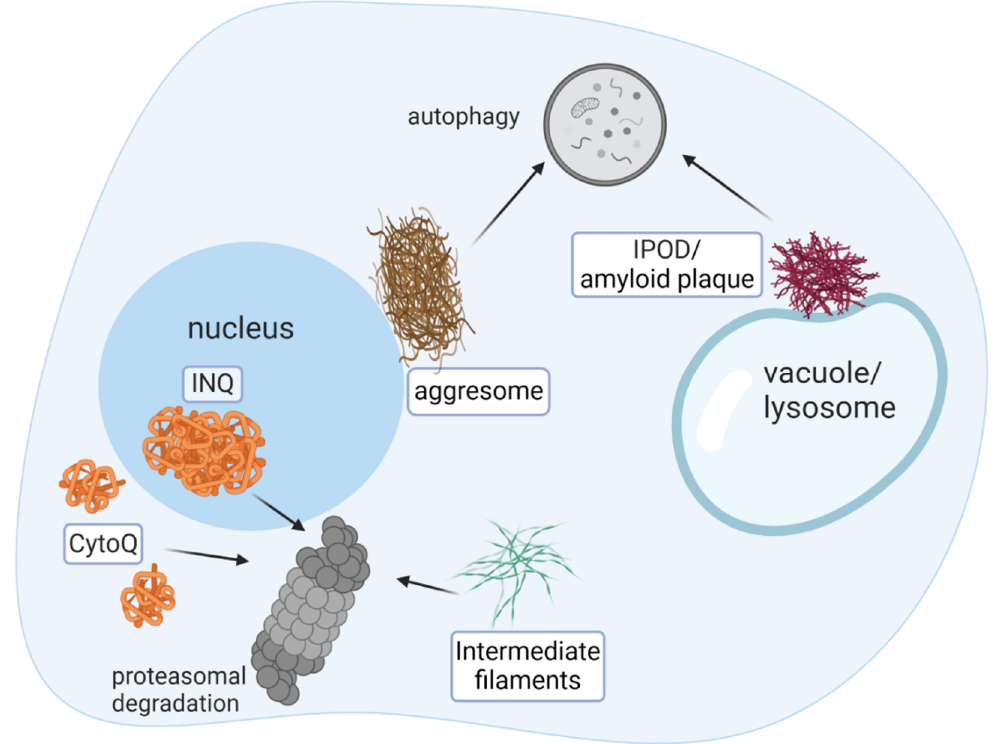
Figure 1. Misfolded proteins are sequestered in distinct cellular deposition compartments. Cellular inclusions are discerned by their morphology, protein composition, and deposition sites. Clearance of immobile deposits, such as aggresome, IPOD, and other mature amyloid inclusions is carried out predominantly by autophagy, while, transient-QC bodies, composed of intermediate filament, Cyto-Q and INQ are degraded by the 26S proteasome. Nearly all inclusions (except for aggresomes) are conserved in evolution, from yeast to human. The principles of the inclusion clearance mechanism are conserved as well.